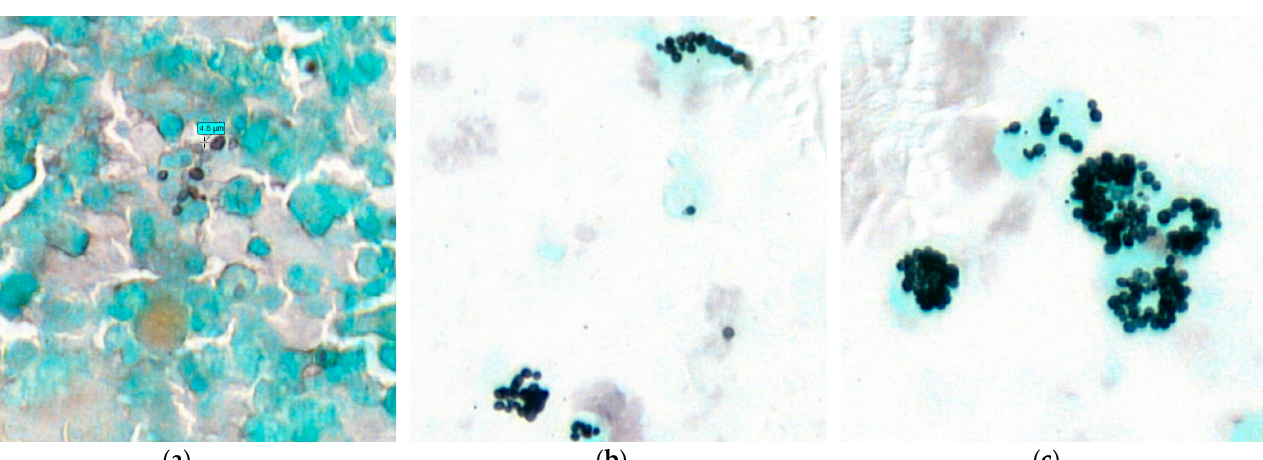
Figure 2. The number of Histoplasma capsulatum by hot spots with the Gomori-Grocott stain (light microscopy at ×40). ( a ) Shows numerous intracellular and extracellular yeasts by hot spots in a patient with a CD4 count of <200 cells/mm 3 . ( b ) Shows a few isolated yeasts sometimes arranged in small clusters.